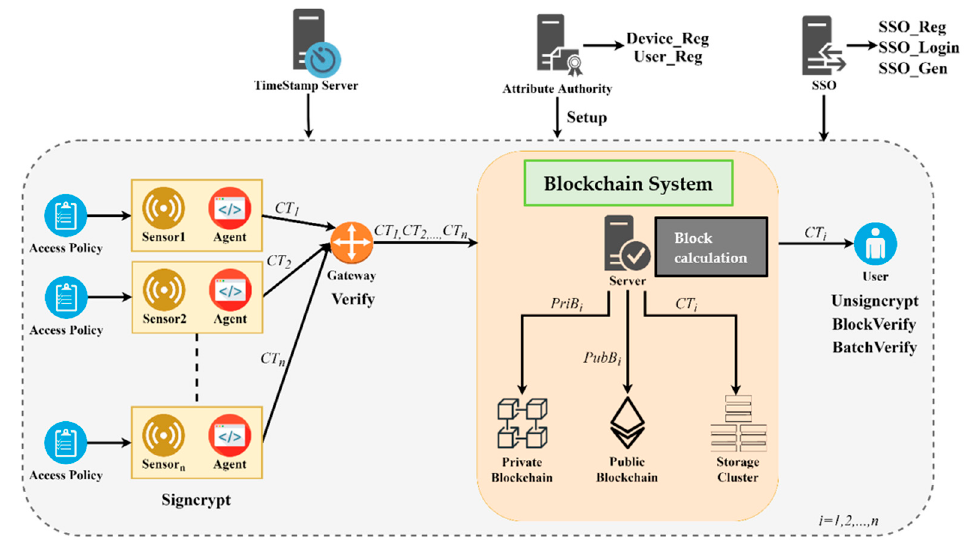
Figure 1. System model of the proposed protocol.